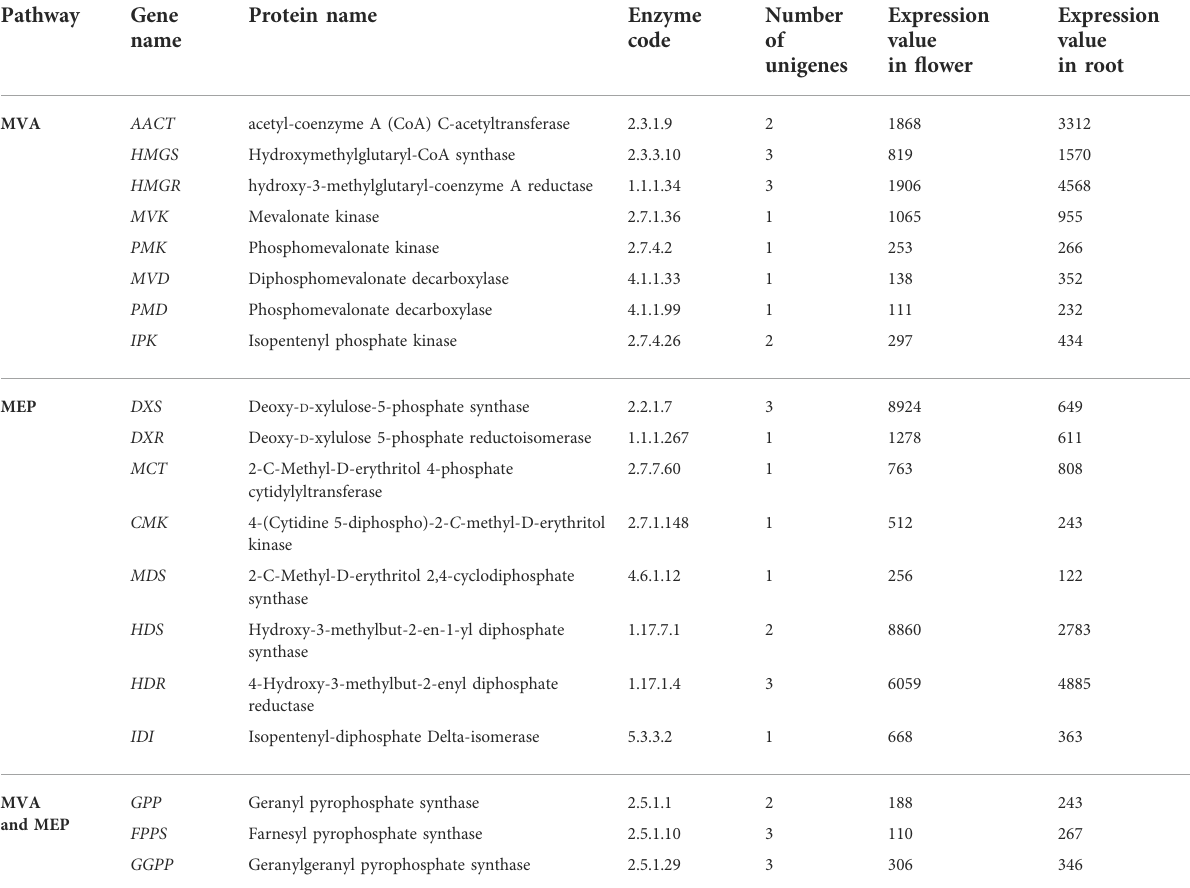
TABLE 6 List of genes involved in terpenoids biosynthesis and their corresponding expression in the fl ower and the root tissue of the Oliveria decumbens Vent.